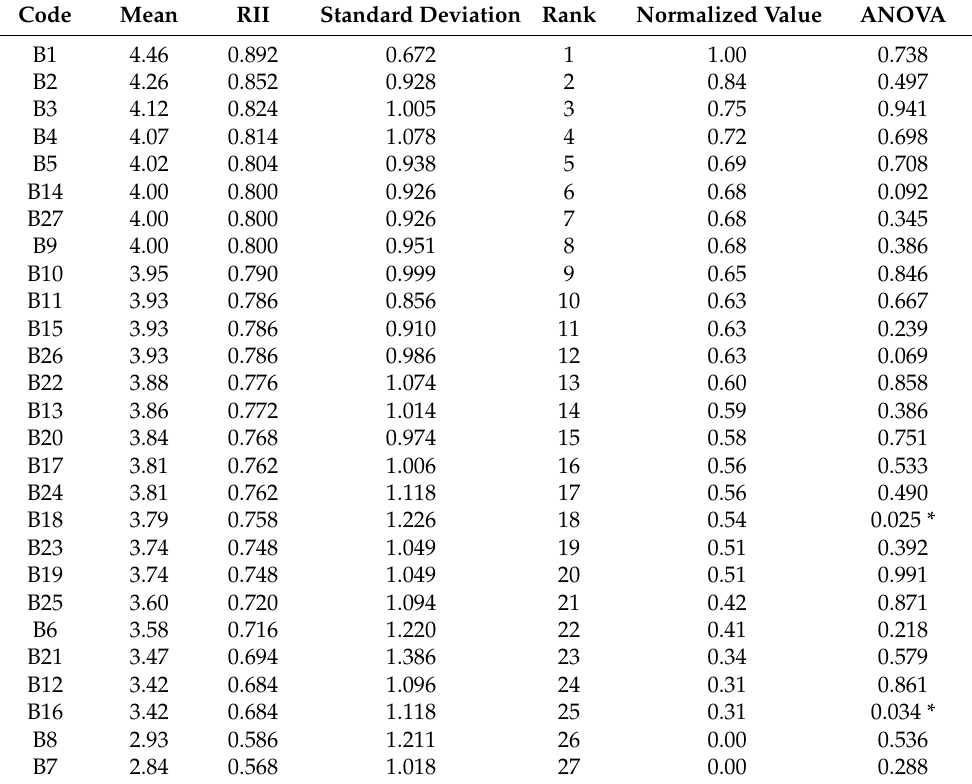
Table 3. RII ranking of